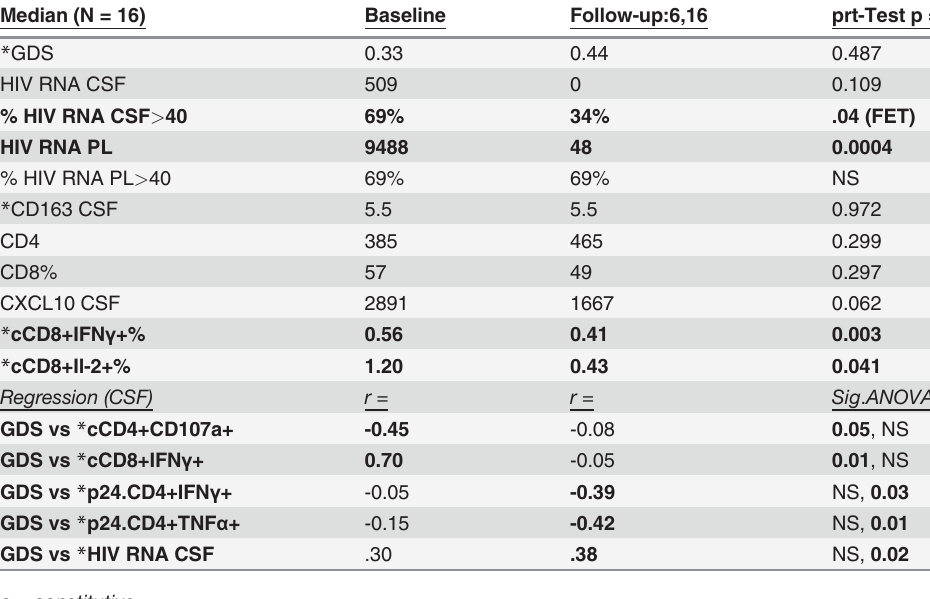
Table 6. Longitudinal analysis con fi rms correlation between NC impairment and CD8+IFN γ + (positive) and lytic activity (negative) at baseline and reveals positive association between NC impairment and residual HIV RNA in CSF at follow-up.